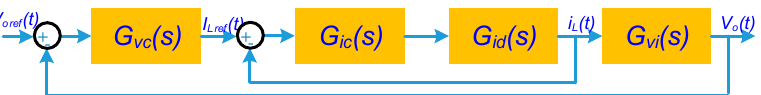
11 of 19 Figure 6. Set of probable equilibrium points: ( a ) output voltage-to-duty ratio ( V o / d ); ( b ) input cur- rent-to-duty ratio ( I in / d ); ( c ) capacitor voltage-to-duty ratio ( V c / d ); ( d ) input current-to-input voltage ( I in / V in ) transfer functions of the IDDB and IDCCB. From Tables 1 and 2, one can evaluate the current-to-duty ratio transfer function of (40), which results in the transfer function being presented in (42): 5